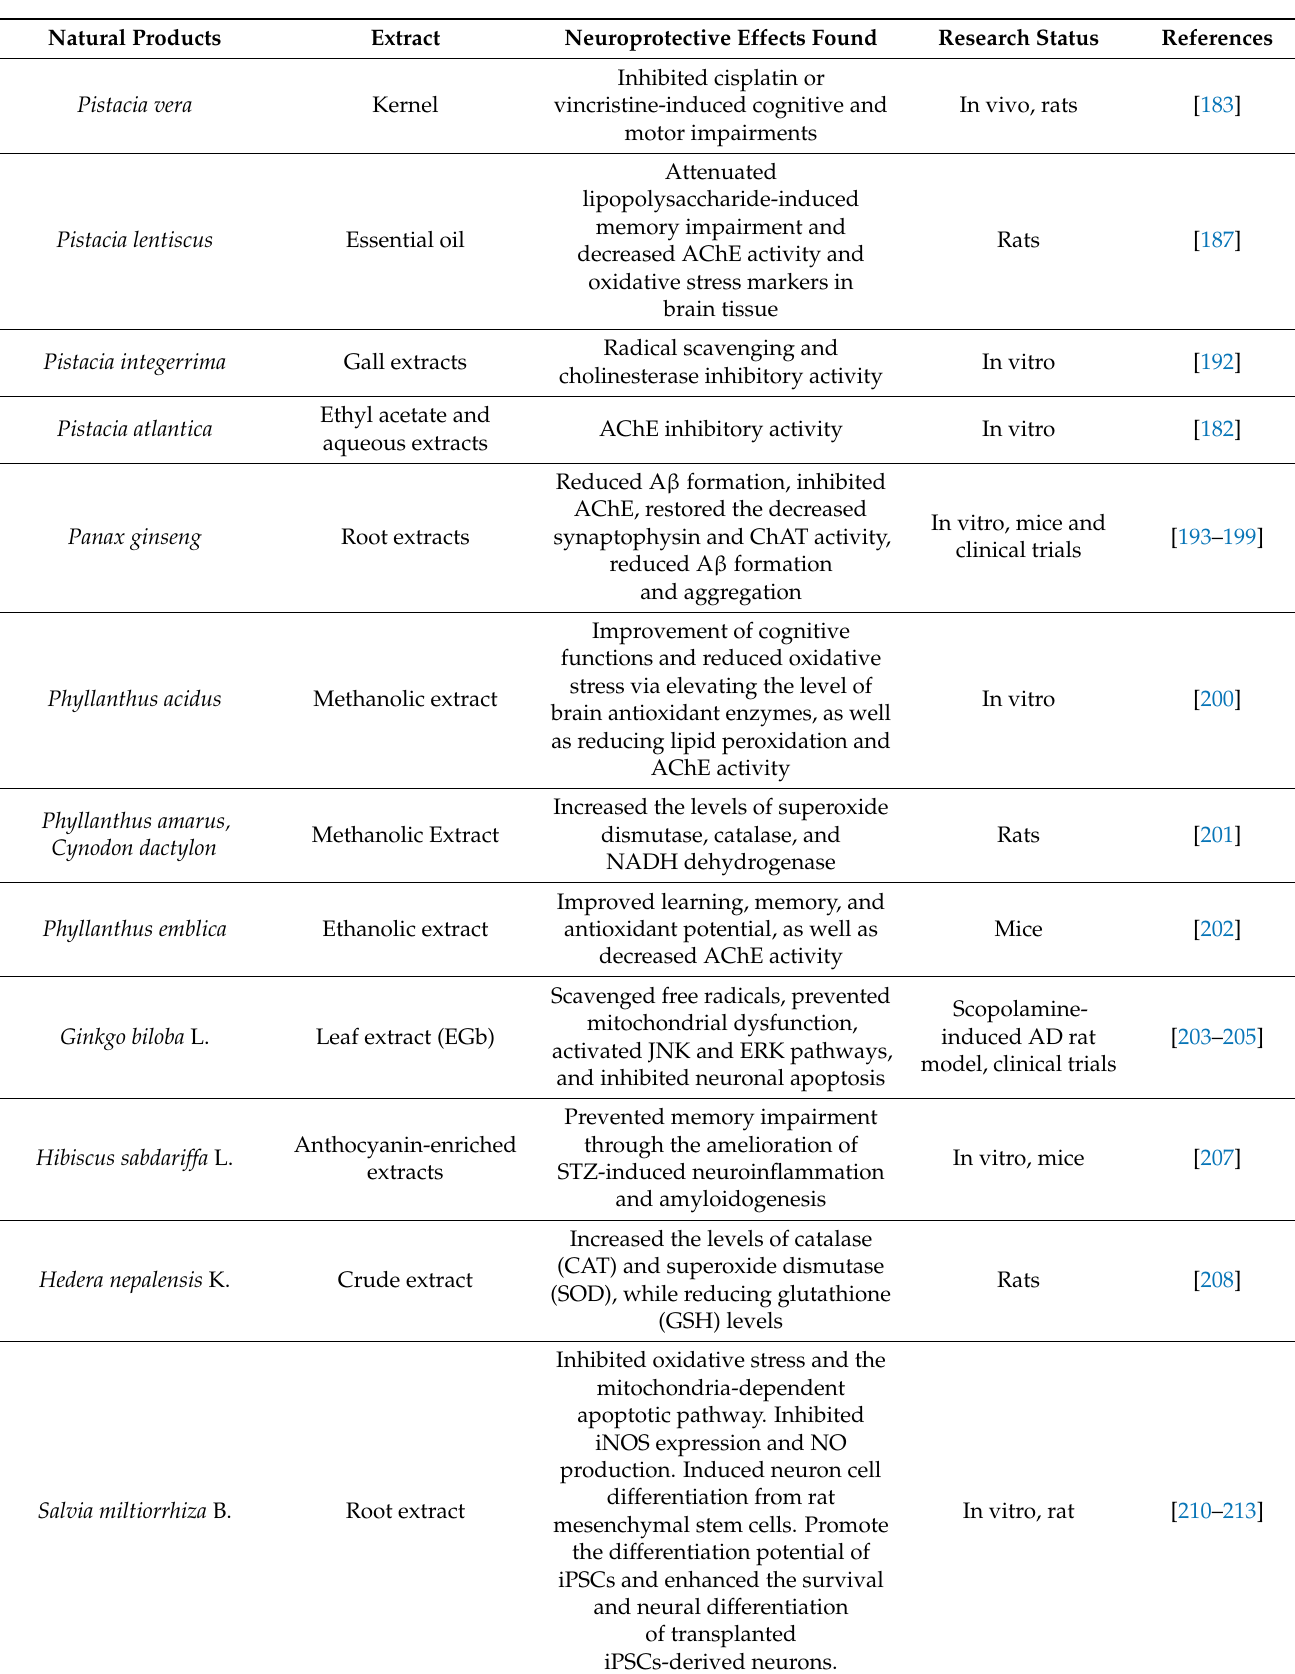
Table 1. Status of Neuroprotective Natural Products Extracts and